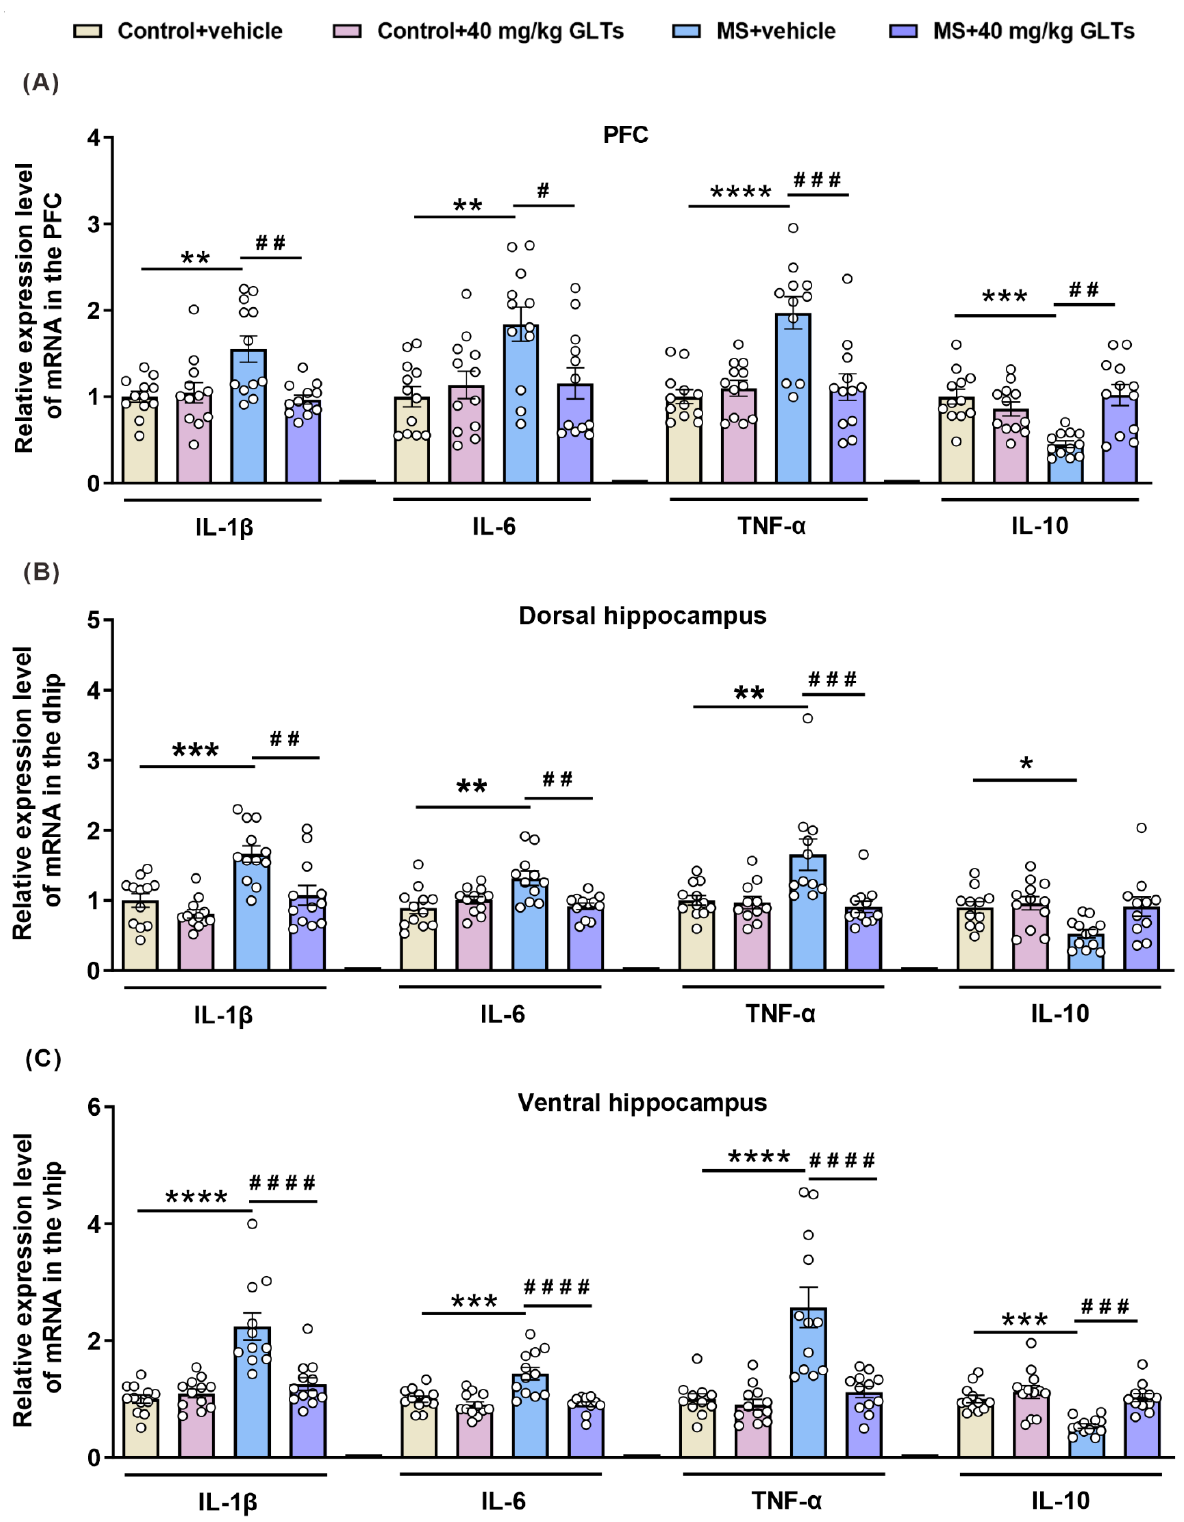
Figure 4. The GLTs-balanced expressions of inflammatory and anti-inflammatory factors in the PFC and hippocampus of the MS mice. ( A – C ) IL-1 β , IL-6, TNF- α , and IL-10 level in the PFC ( A ), dorsal hippocampus ( B ), and ventral hippocampus ( C ) of mice. Data are expressed as mean ± SEM, n = 12/group. * p < 0.05, ** p < 0.01, *** p < 0.001, **** p < 0.0001, as compared with Control + vehicle group; # p < 0.05, ## p < 0.01, ### p < 0.001, #### p < 0.0001, as compared with MS + vehicle group.